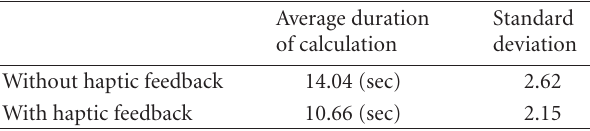
Figure 7: Calculator and presented equations. Table 3: E ff ectiveness button pressing sense